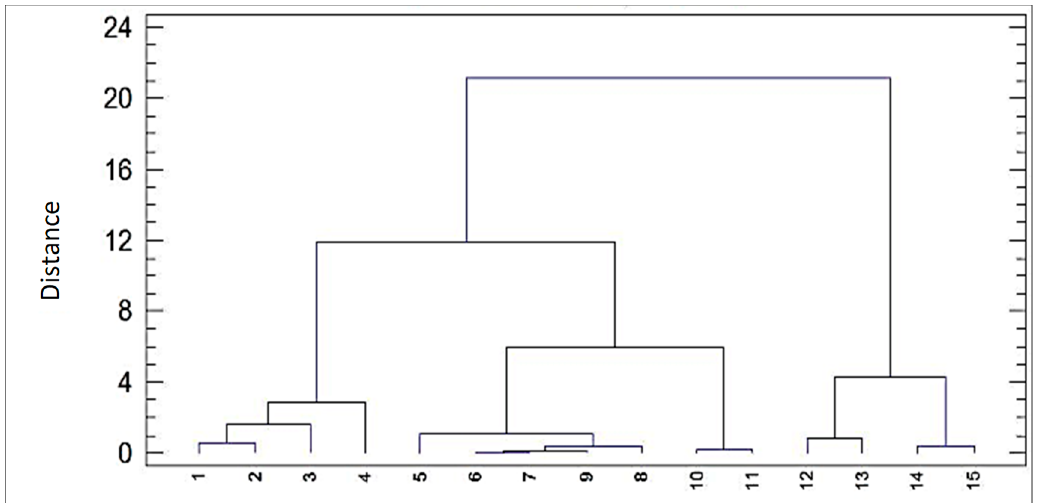
Figure 6. Observation dendrogram (on the “x” axis the sampling points are represented and on the “y” axis the proximity distance between the sampled points.